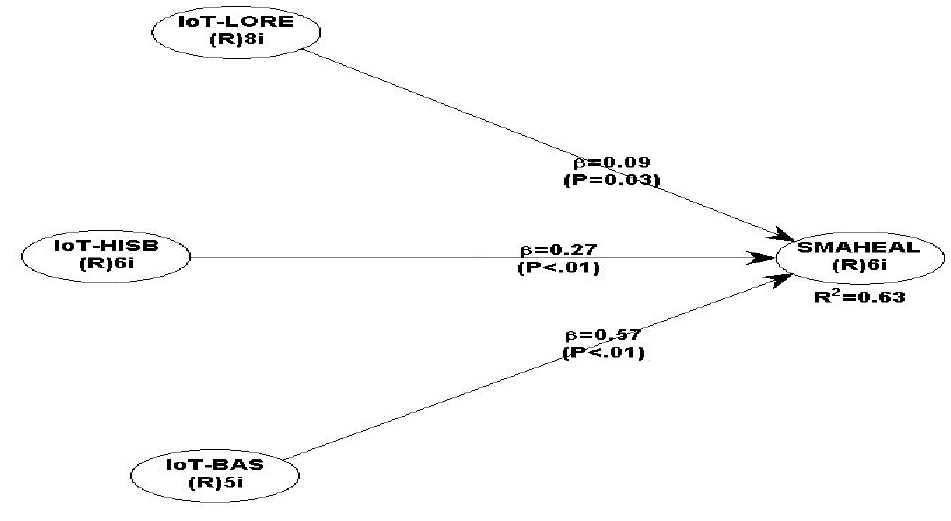
Figure 3. Structural model of the constructs.